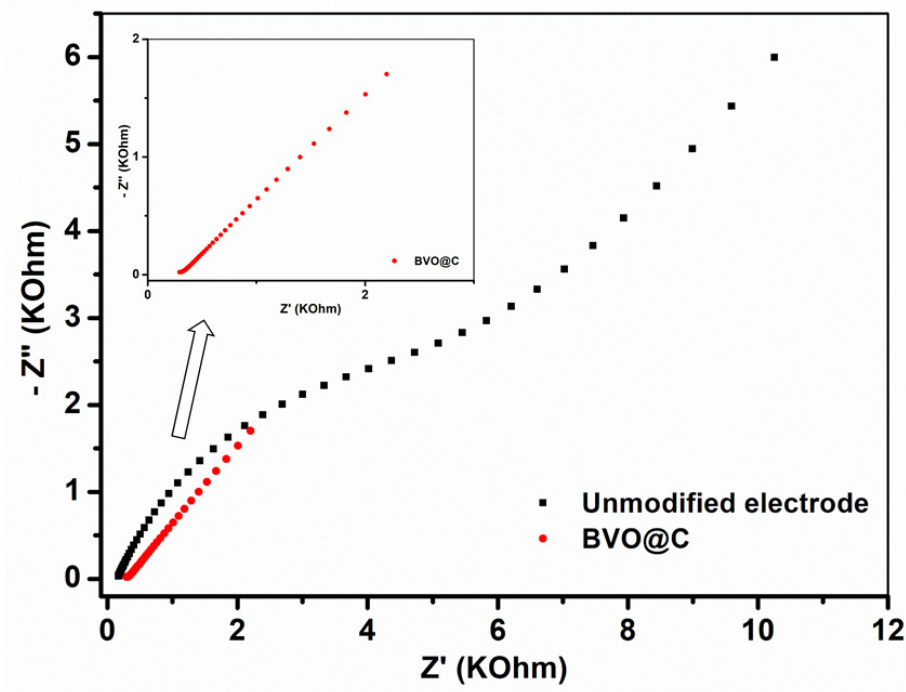
Figure 5. Nyquist diagram for the EIS measurements in 0.05 mol L − 1 potassium ferrocyanide in 0.1 mol L − 1 KCl for different electrode configurations.